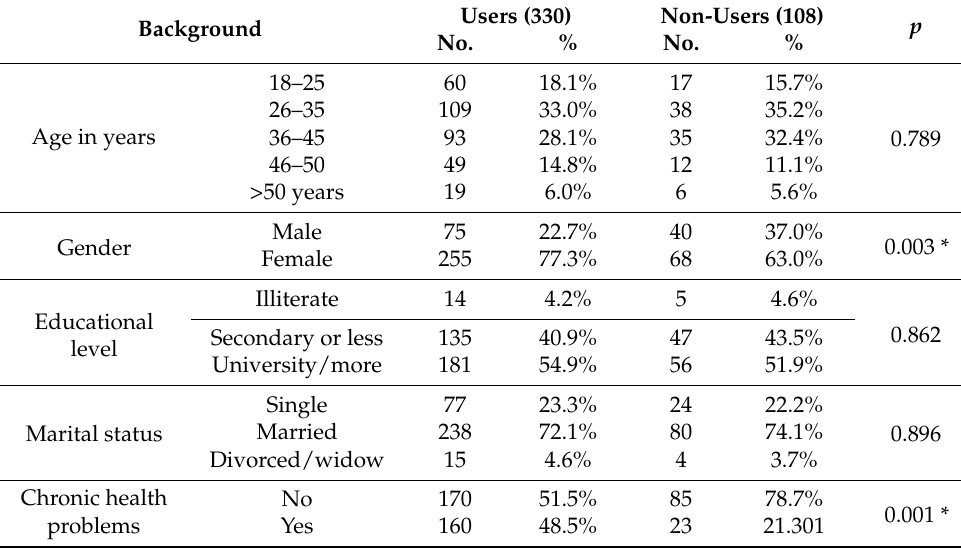
Table 2. Distribution of dietary supplement use by participants’